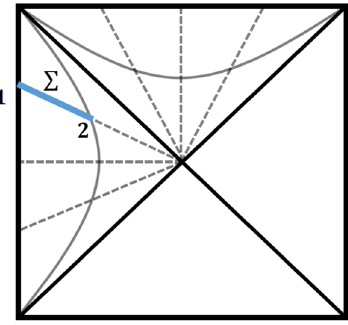
Fig. 3 The thick blue line indicates our choice of (cid:11) lying on the t = (constant) surface to collect the radiation. The static coordinates of the endpoints 1 and 2 are given by ( t 1 , r 1 ) = ( t , 0 ) and ( t 2 , r 2 ) = ( t , r ) ,